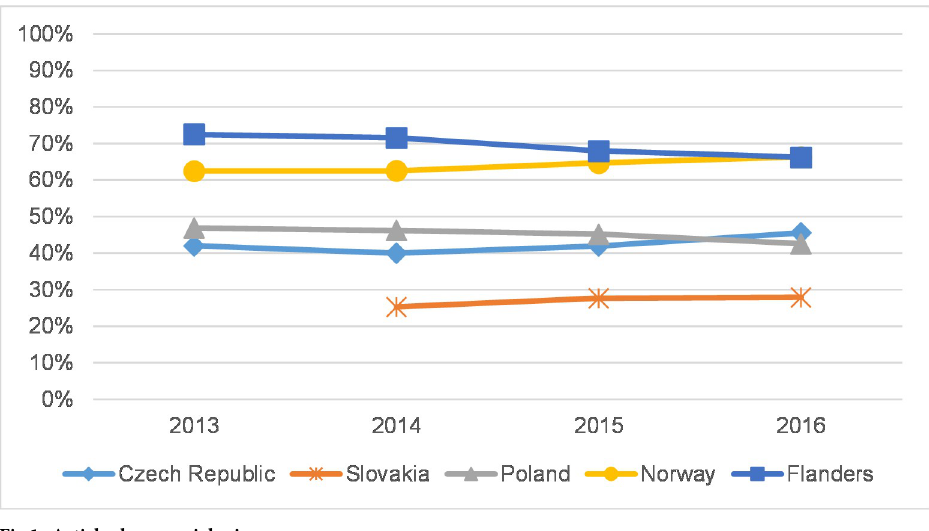
Fig 1. Article share–social